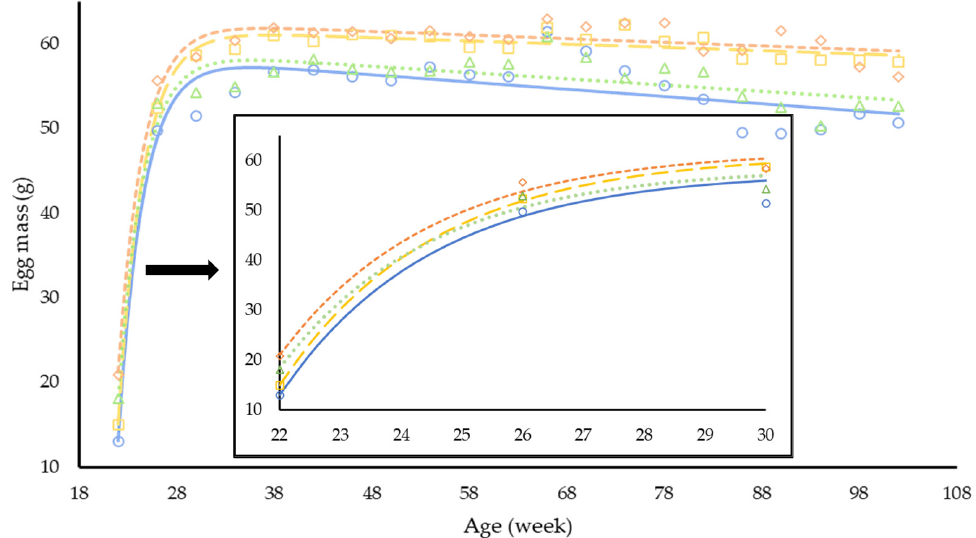
Figure 2. Observed and predicted egg mass (g) of laying hens from 19 to 102 weeks of age in response to levels of dietary balanced protein. Treatments: LL ( ○ , — ) and HH ( ◊ , - - ) are low and high dietary balanced protein treatments, respectively; LH ( □ , – – ) and HL ( ∆ , ∙∙∙ ) are the repletion and depletion in dietary BP applied to laying hens from 19 to 102 weeks of age.